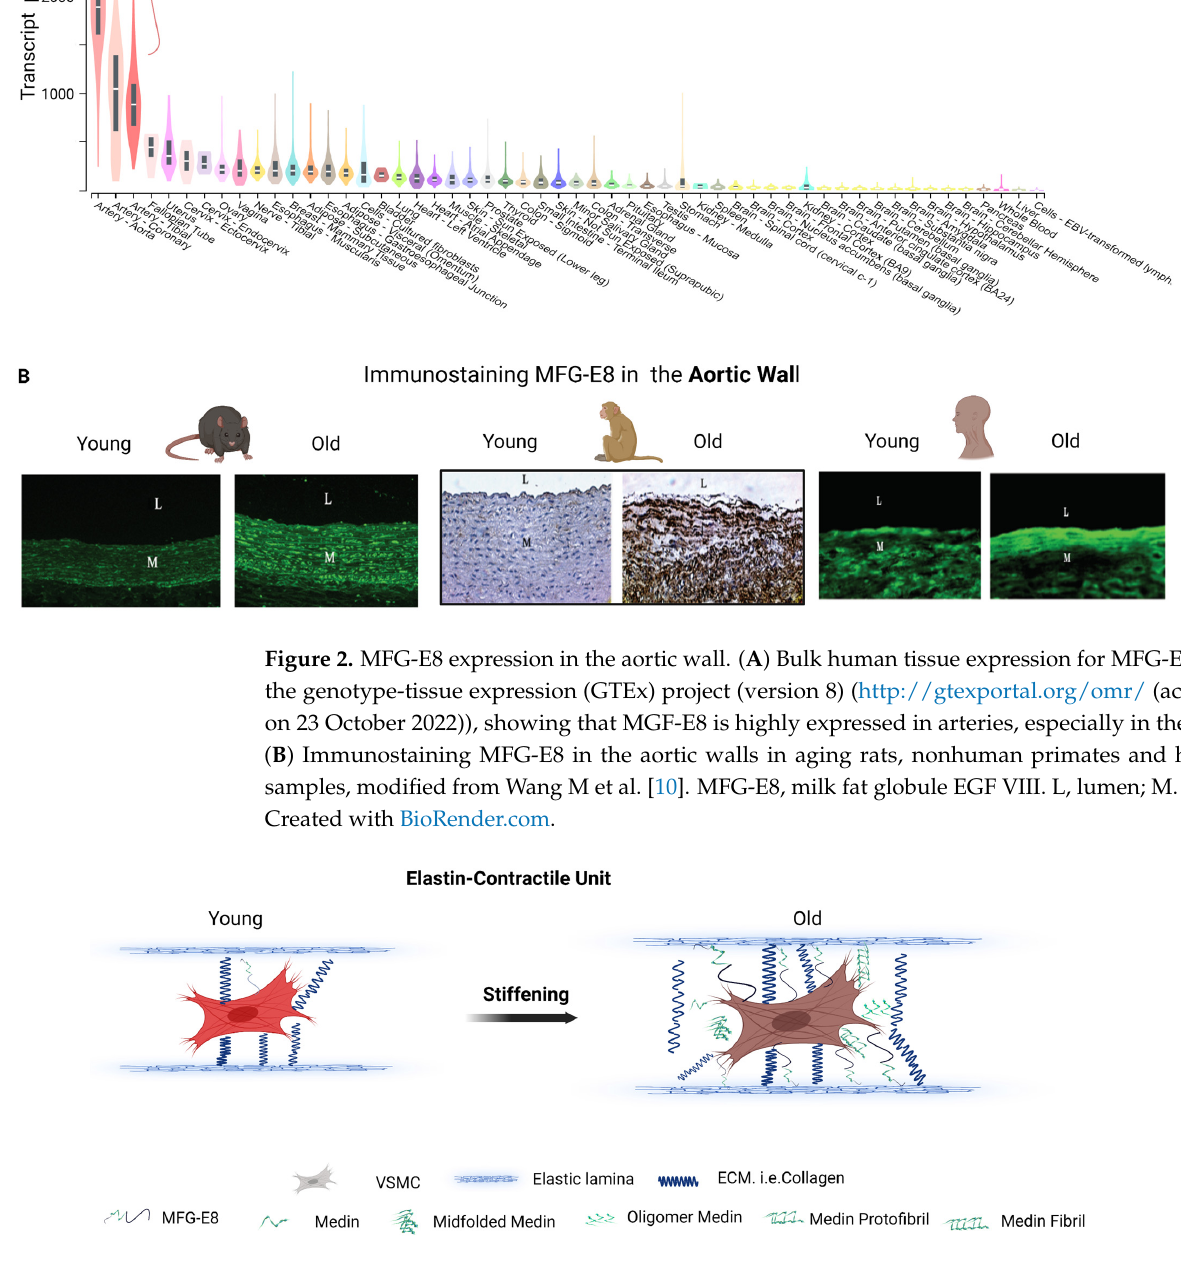
Figure 3. Elastin-contractile unit in the vascular wall. A schematic depiction of remodeling of the arterial elastin-contractile unit with aging, focusing on MFG-E8/medin. MFG-E8/medin acts as a bridging molecule (linker) between the elastic lamina and VSMCs which is involved in the stiffening of the vascular elastin-contractile microstructure with aging. Cleavage of MFG-E8 to release medin will break this bridge/linkage. Medin may compete with MFG-E8 in the binding to elastic fiber forming a linear amyloid fibril or aggregates as a non-amyloid oligomer, which promotes vascular microstructure stiffening in advanced age. ECM, extracellular matrix; VSMCs, vascular smooth muscle cells; MFG-E8, milk fat globule EGF VIII. Created with